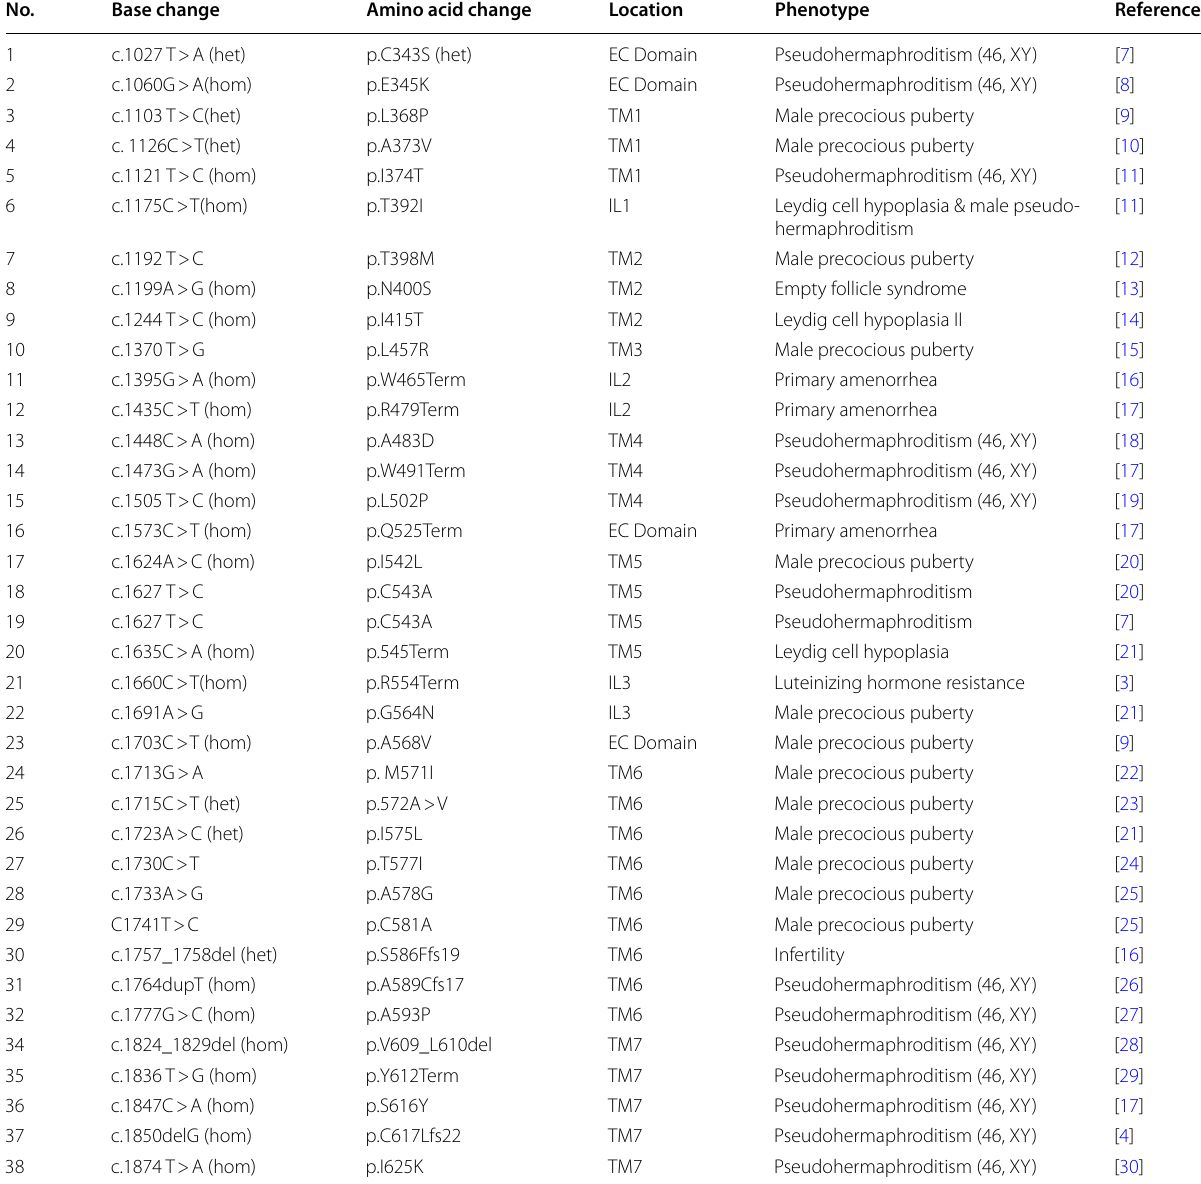
EC Extracellular, TM transmembrane segment, IL intracellular loop, fs Frame shift, Term Terminal Codon, hom Homozygote, het Heterozygote